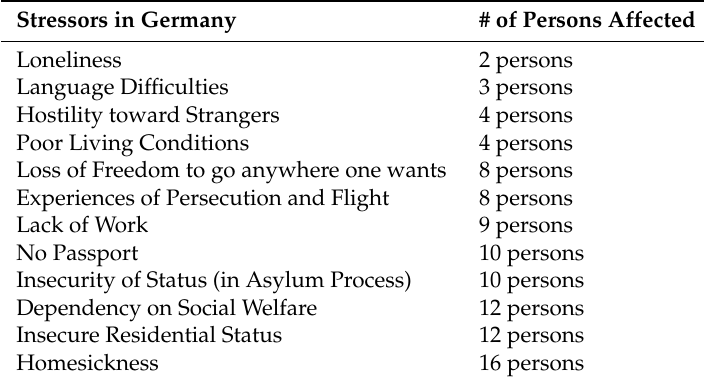
Table 2. Most serious stressors in Germany (N =